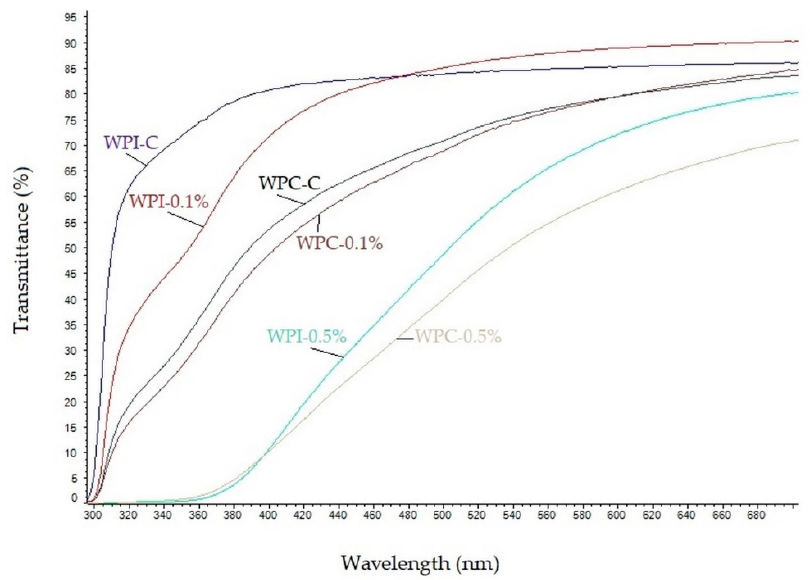
Figure 2. UV–Vis spectra of neat and modified WPC/WPI films.